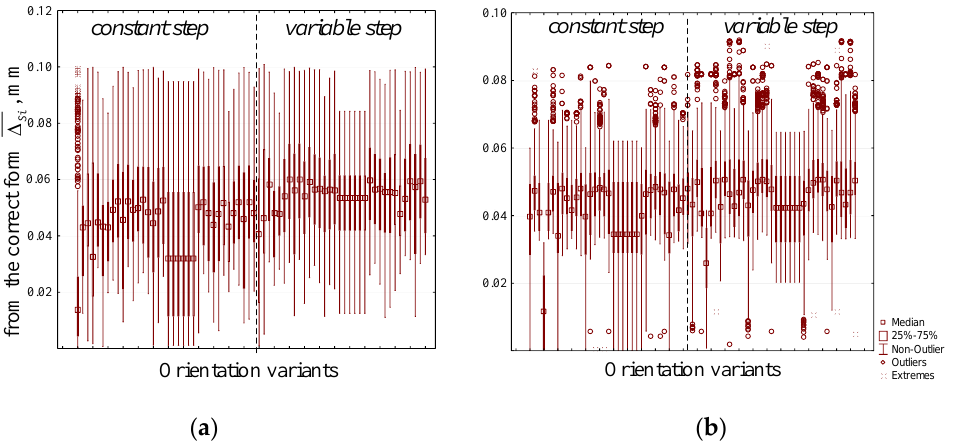
Figure 6. Statistical layered analysis of the arithmetic mean value of deviations from the correct surface of the 3D models: ( a ) Analysis results from the 1st test 3D model (Figure 2a); ( b ) Analysis results from the 2nd test 3D model (Figure 2b).